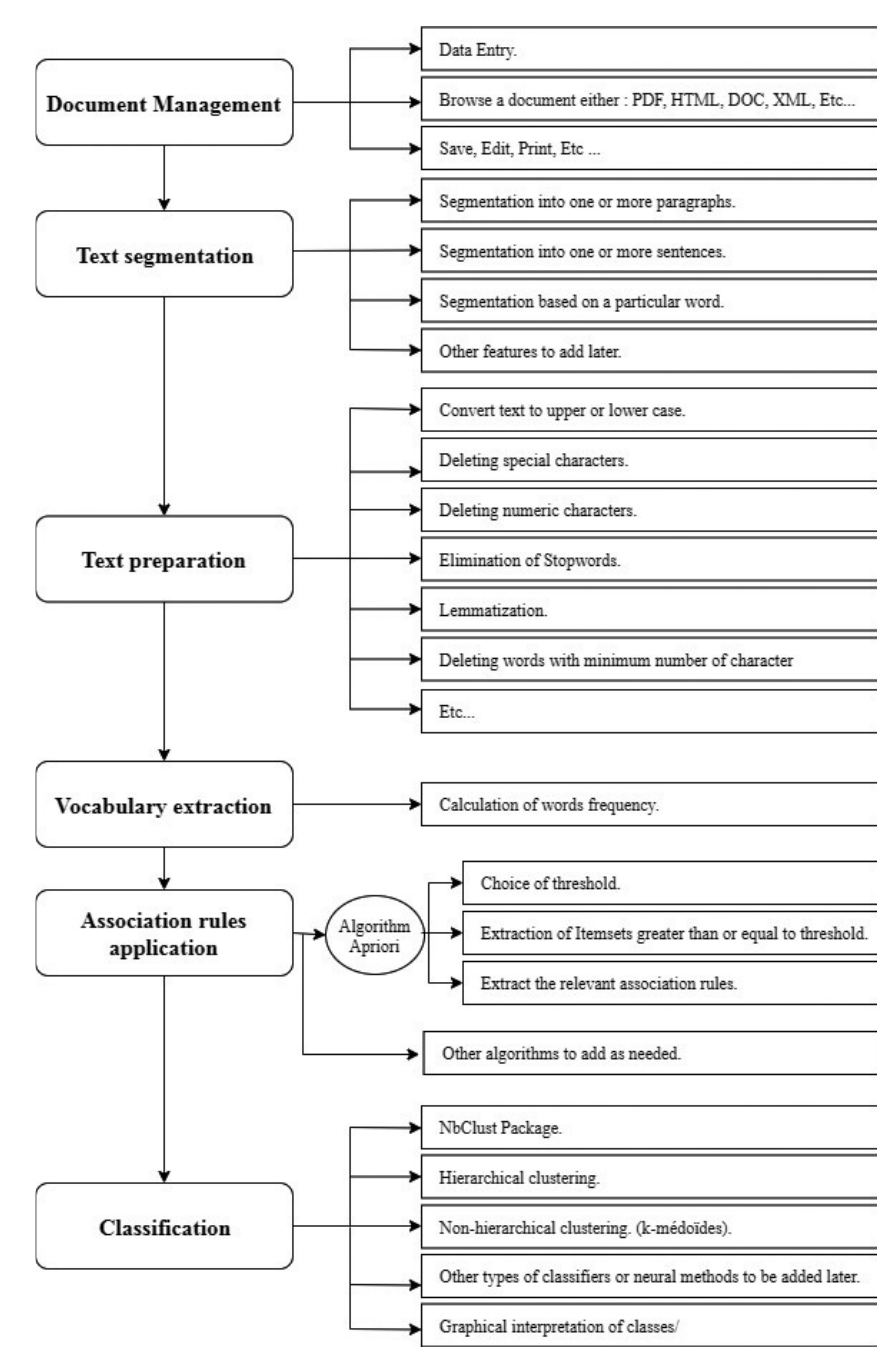
Fig. 3. Functionalities of the platform